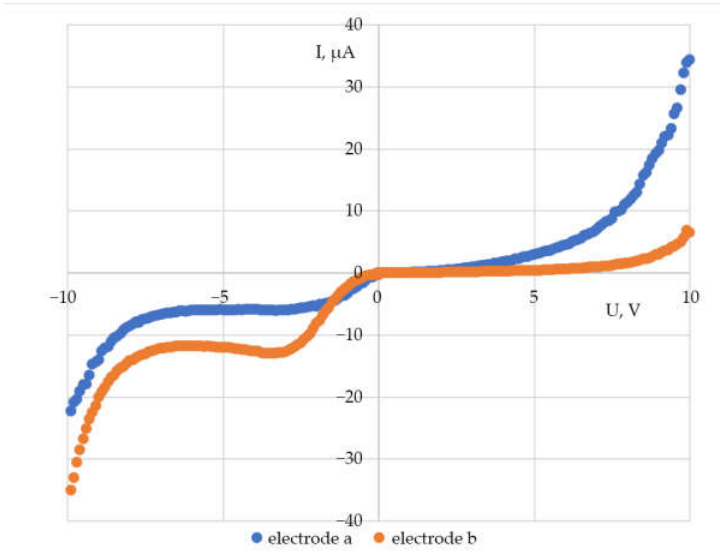
Figure 8. The current–voltage characteristics of the sample taken with electrodes (a) and (b).